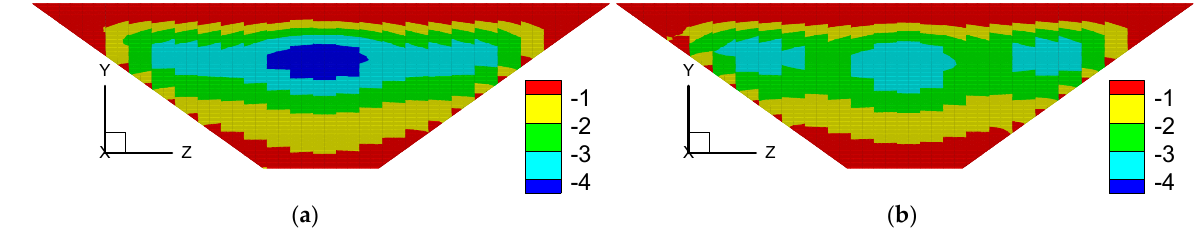
Figure 23. Maximum distribution of concrete face slabs’ tensile stresses along the slope direction (MPa): ( a ) Neglecting hydrodynamic pressure and ( b ) the Polyhedron SBFEM.